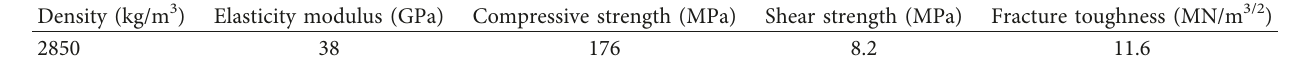
Table 3: Material parameters of RPC.